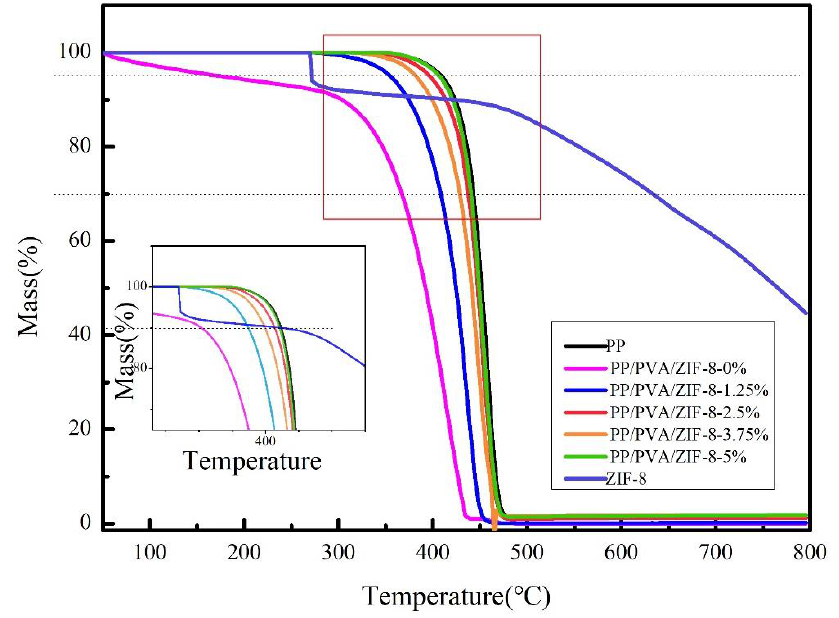
Figure 10. Thermogravimetric (TG) curves of PP melt-blown membranes and PP / PVA / ZIF-8 melt-blown electrospun composite membranes.